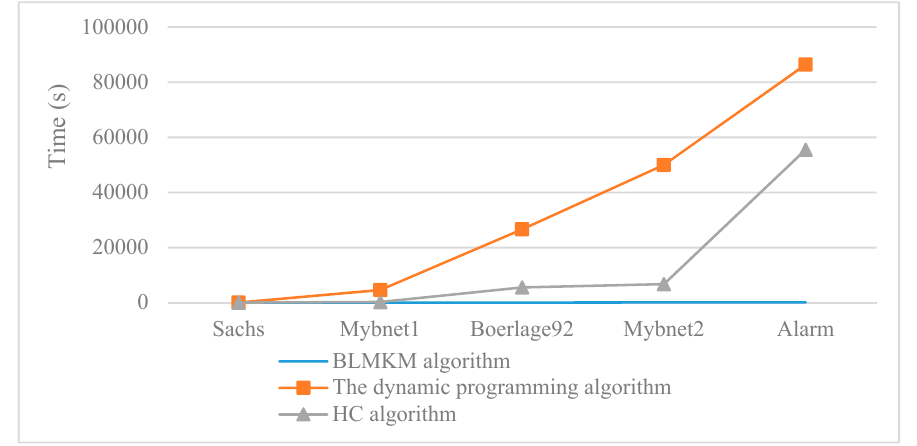
Figure 7. The comparison of running time between a BLMKM algorithm and other non-blocking classical structure learning algorithms.